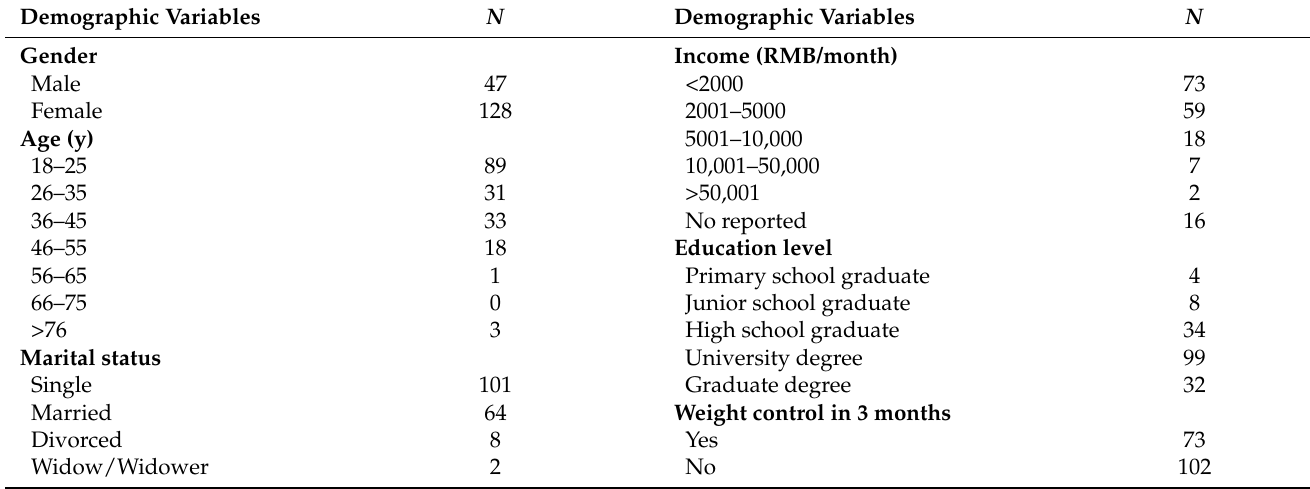
Table 1. Demographic characteristics of the participants in sample A ( N =